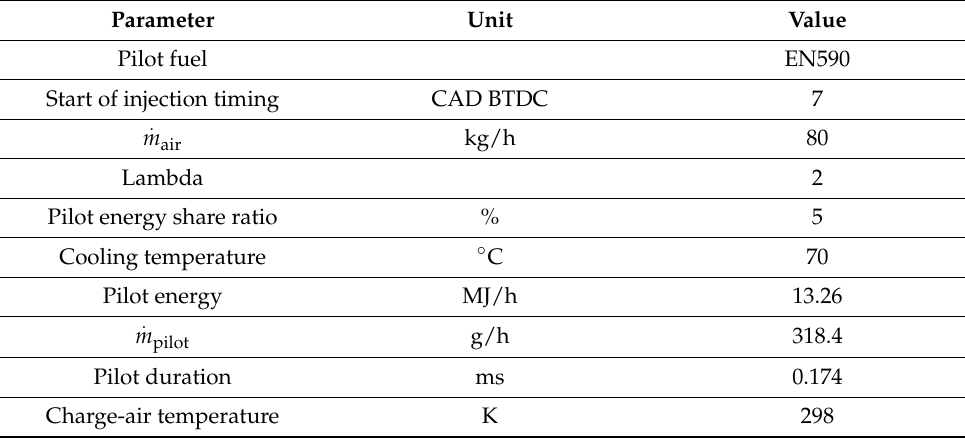
Table 3. Overview of the engine operating conditions.